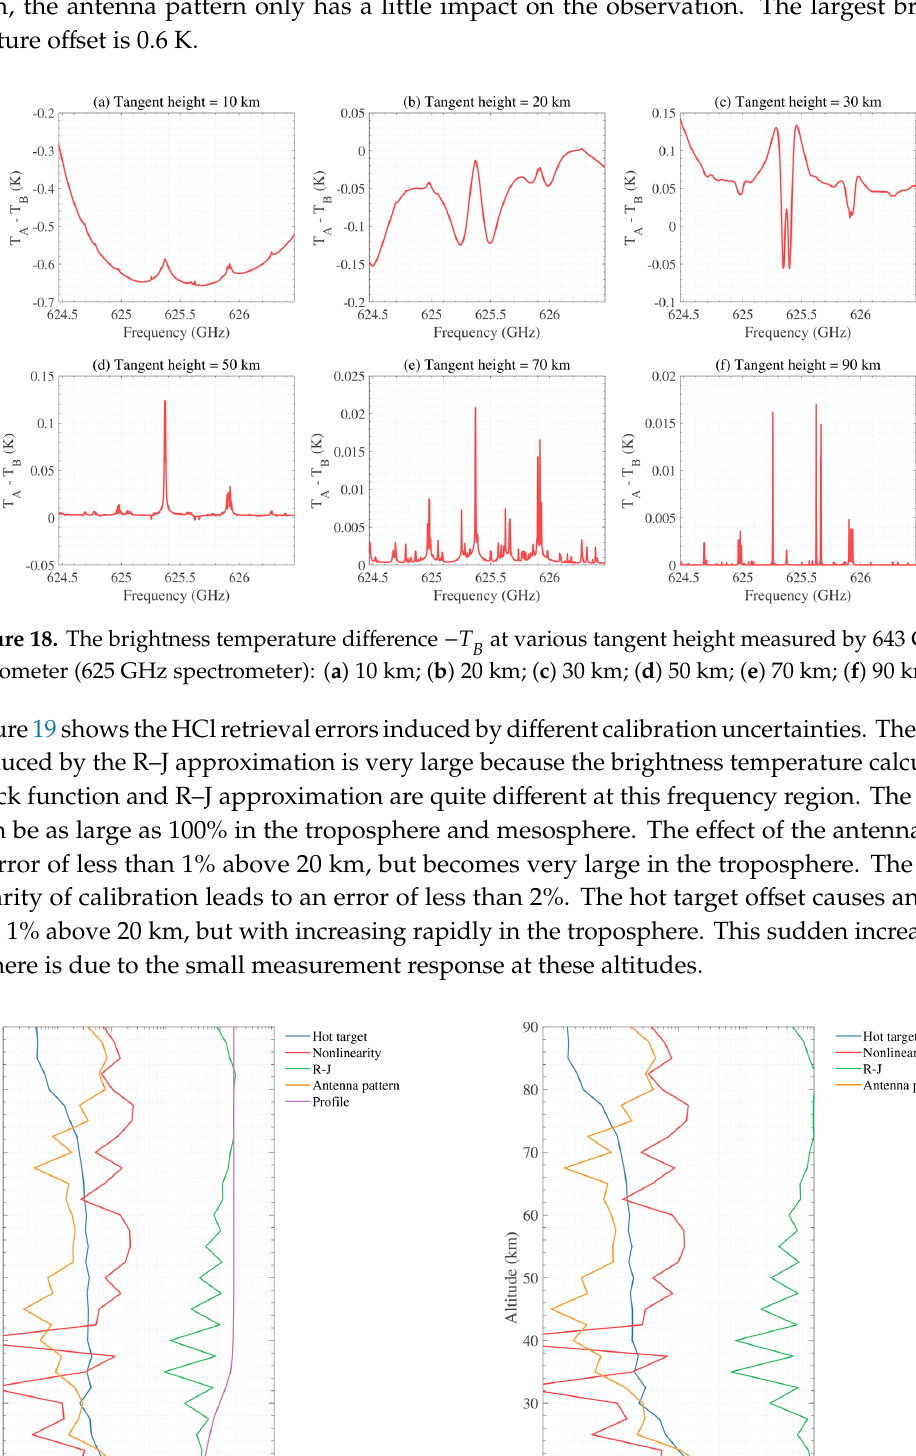
Figure 20. The HCl retrieval error induced by external error source: ( a ) absolute and ( b ) relative retrieval errors. The uncertainties assumed are summarized in Table 5. 4.5. Overall Error Estimation The errors above are simulated independently, keeping the rest of the parameters ideal. The overall error can be calculated by using the sum of the squared errors. R–J approximation is not included, since this error can be avoided by the Planck unit. Figure 21 shows the overall errors of the four radiometers. The errors of temperature are < 3 K from 27 to 57 km. The instrument uncertainties play the most important role above 45 km, while the calibration errors dominate below.